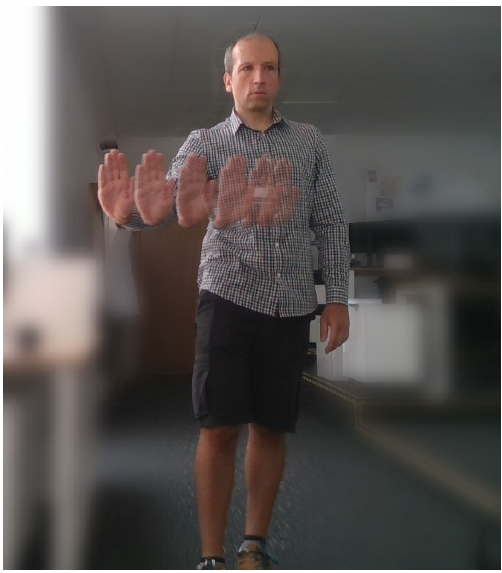
Figure 28. Sample dynamic gesture: wave right.